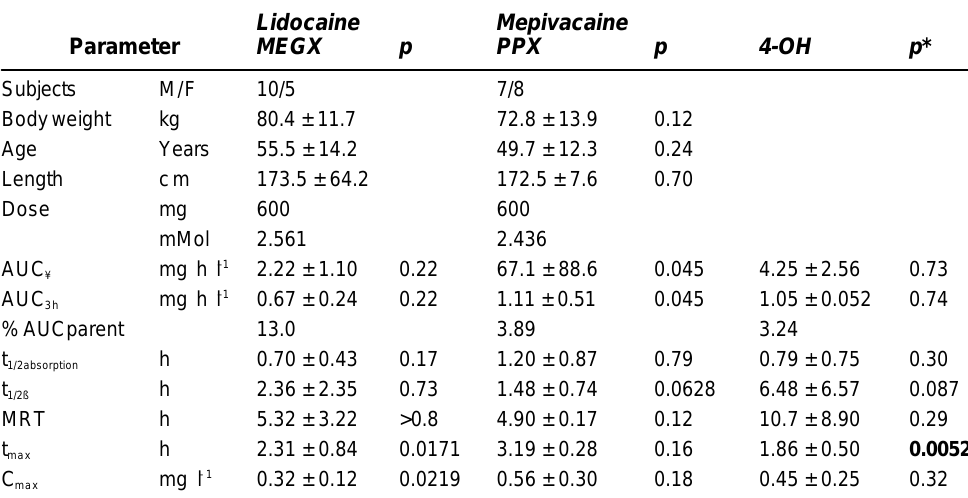
Comparison of the Pharmacokinetic Parameters (Mean ± s.d.) of the Lidocaine and Mepivacaine Metabolites MEGX, 4-OH, and PPX after